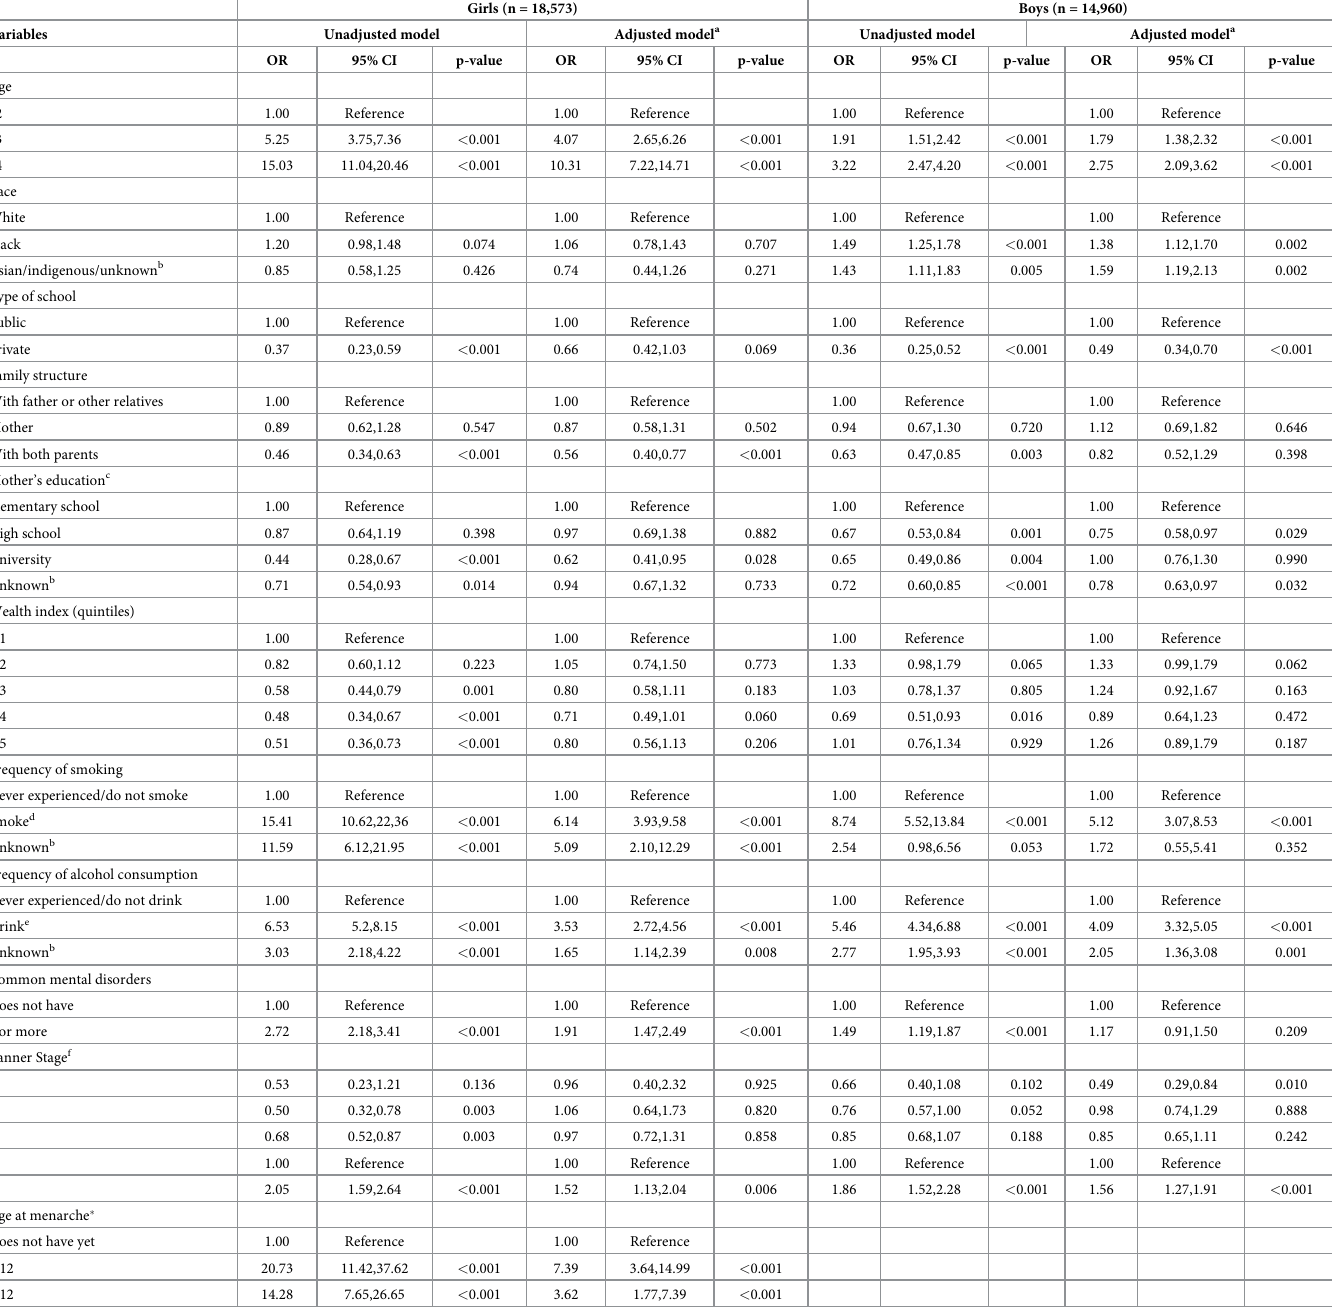
Table 2. Unadjusted and adjusted Odds Ratios (OR) and 95% confidence intervals (CI) of the associations between early sexual initiation (ESI) and adolescent’s characteristics in girls and boys, ERICA study,